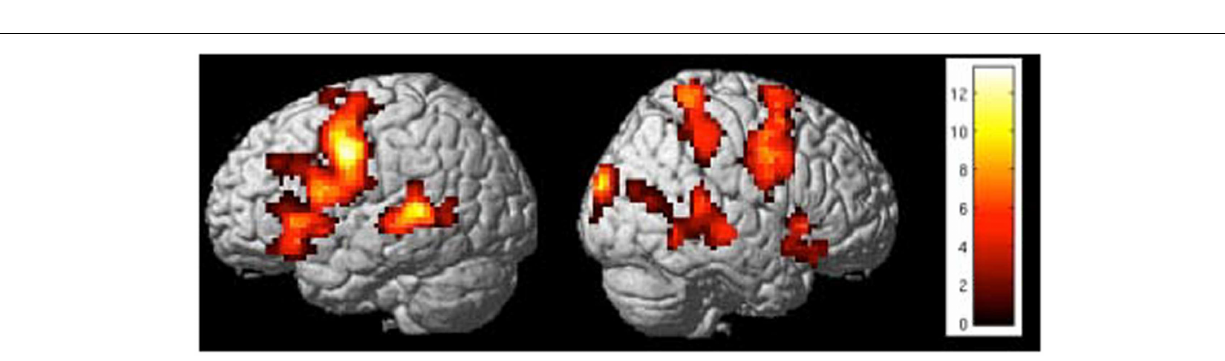
FIGURE 8 | “Activation clusters for the contrast up-regulation vs. baseline during the last session of self-regulation training in a representative subject.” Important brain activations can be seen in posterior STG and frontal areas (included IFG) in the left hemisphere [ p < 0.05 (FWE), extent threshold k =